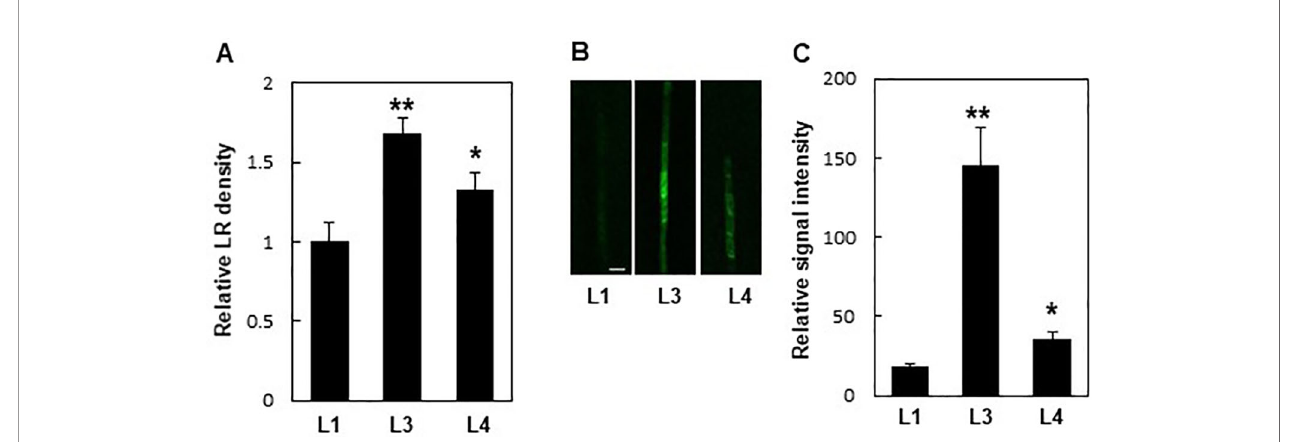
FIGURE 3 | Expression levels of PIN8 are related to lateral root (LR) density. (A) LR densities of three independent ProPIN8:PIN8:GFP transgenic lines. Data represent mean ± SE ( n = 27 – 66 seedlings). (B) Confocal images of the PIN8:GFP signal in the root vasculature of ProPIN8::PIN8:GFP transgenic lines. Scale bar = 20 µm. (C) Relative PIN8:GFP signal in ProPIN8:PIN8:GFP lines. Data represent mean ± SE ( n = 5 seedlings). In ( A, C ), signi fi cant differences compared with L1 intensity are indicated using asterisks (* P < 0.05, ** P < 0.005; Student's t